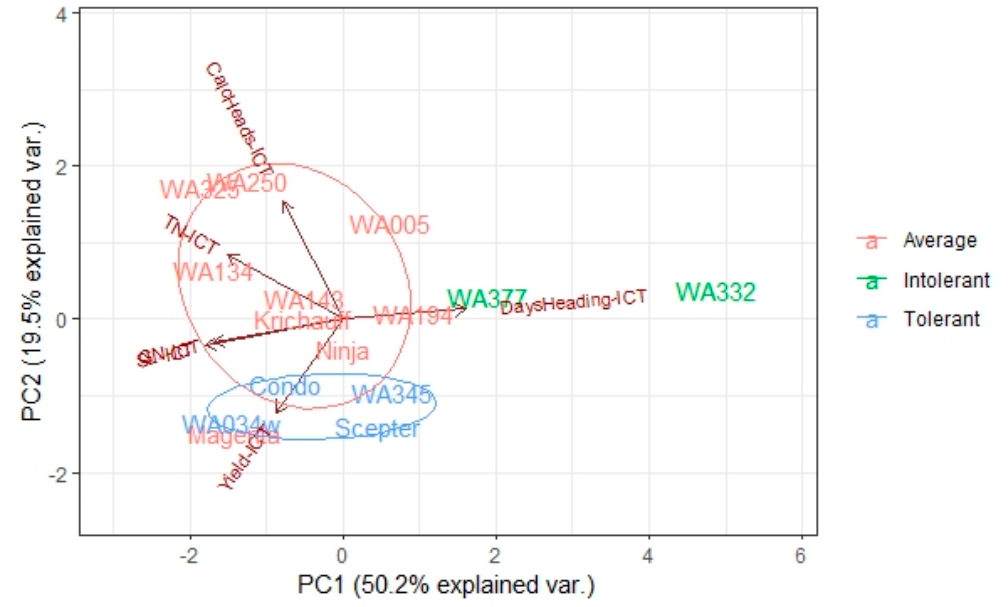
Figure 5. PCA biplot with lines clustered based on Yield-ICT and other traits-ICT. Data are from 2019 TOS1 trial. The “other traits-ICT” include tiller number ICT (TN), grain number ICT (GN) and heads/m 2 ICT (Heads).